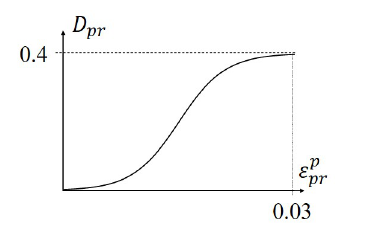
Figure 6. Damage index and principal strain relationship in the tensile